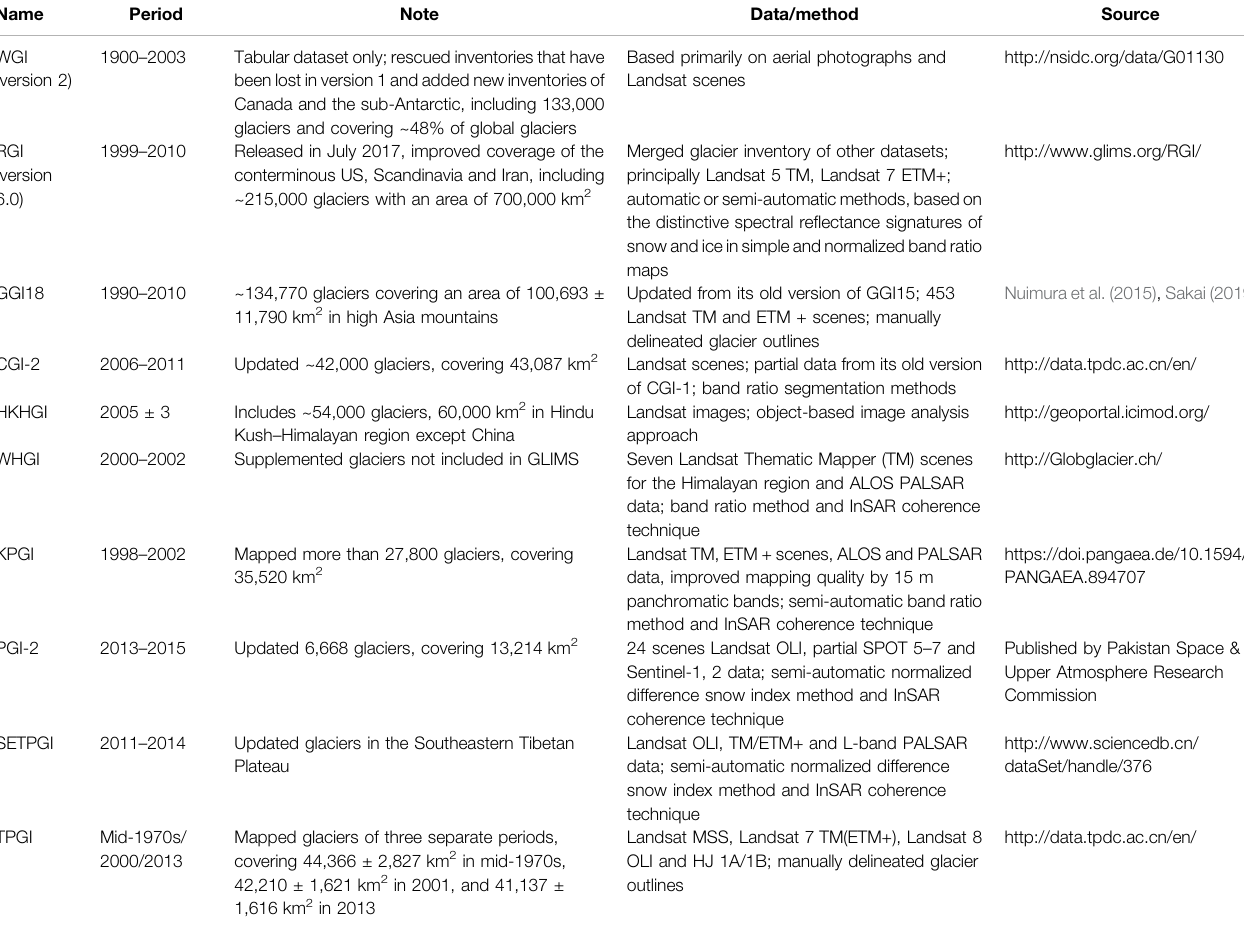
TABLE 1 | Key information about the ten glacier inventories for the